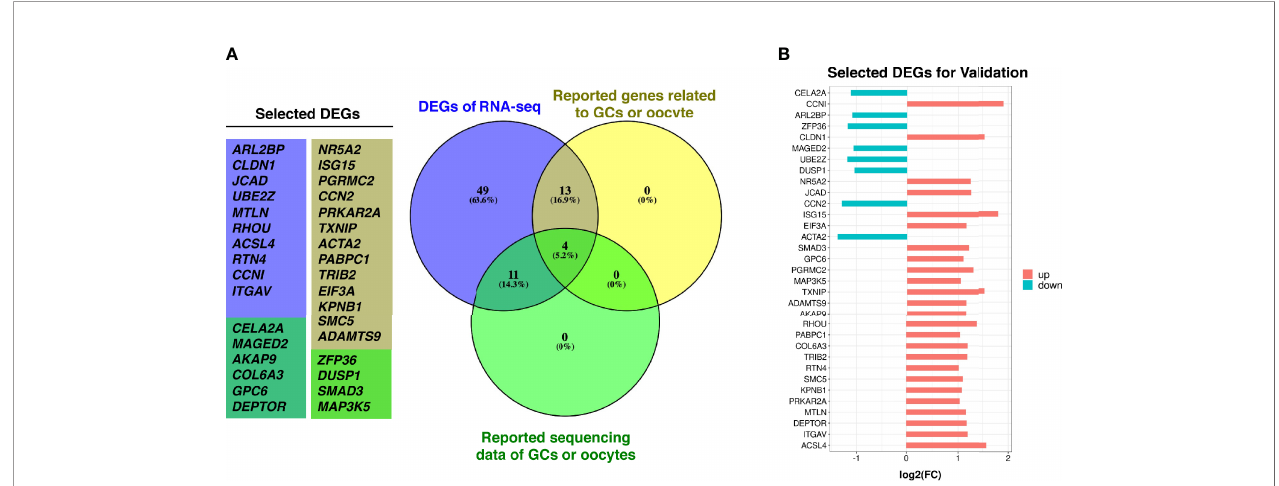
FIGURE 3 | DEGs selection for validation. (A) Purple circle represents DEGs with |log 2 (FC)| ≥ 1, p < 0.08 and FPKM > 0.8 in all samples from this study, yellow circle represents reported genes from the DEGs that are related to GCs/oocyte/follicular development, green circle represents genes from the DEGs are intersected with reported original transcriptomic sequencing data of GCs and OEM-affected oocytes. (B) The log 2 (FC) value of selected DEGs for validation ( N MF = 6, N OEM = 5).